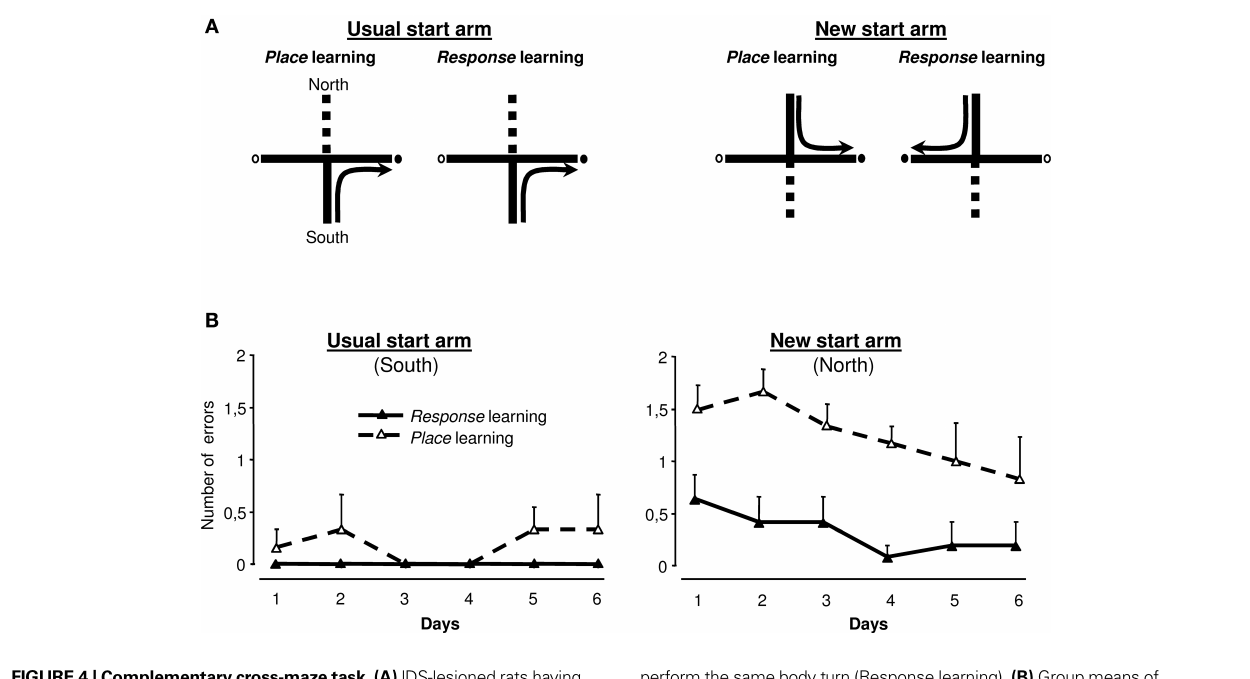
perform the same body turn (Response learning). (B) Group means of number of errors ( ± SEM) made by lDS rats when trained in the modifi ed Response ( n = 6) or Place ( n = 9) cross-maze task. Left: There was no between-group difference for the usual start arm (South). Right: Rats acquired the Response signifi cantly faster than the Place task from the new start arm